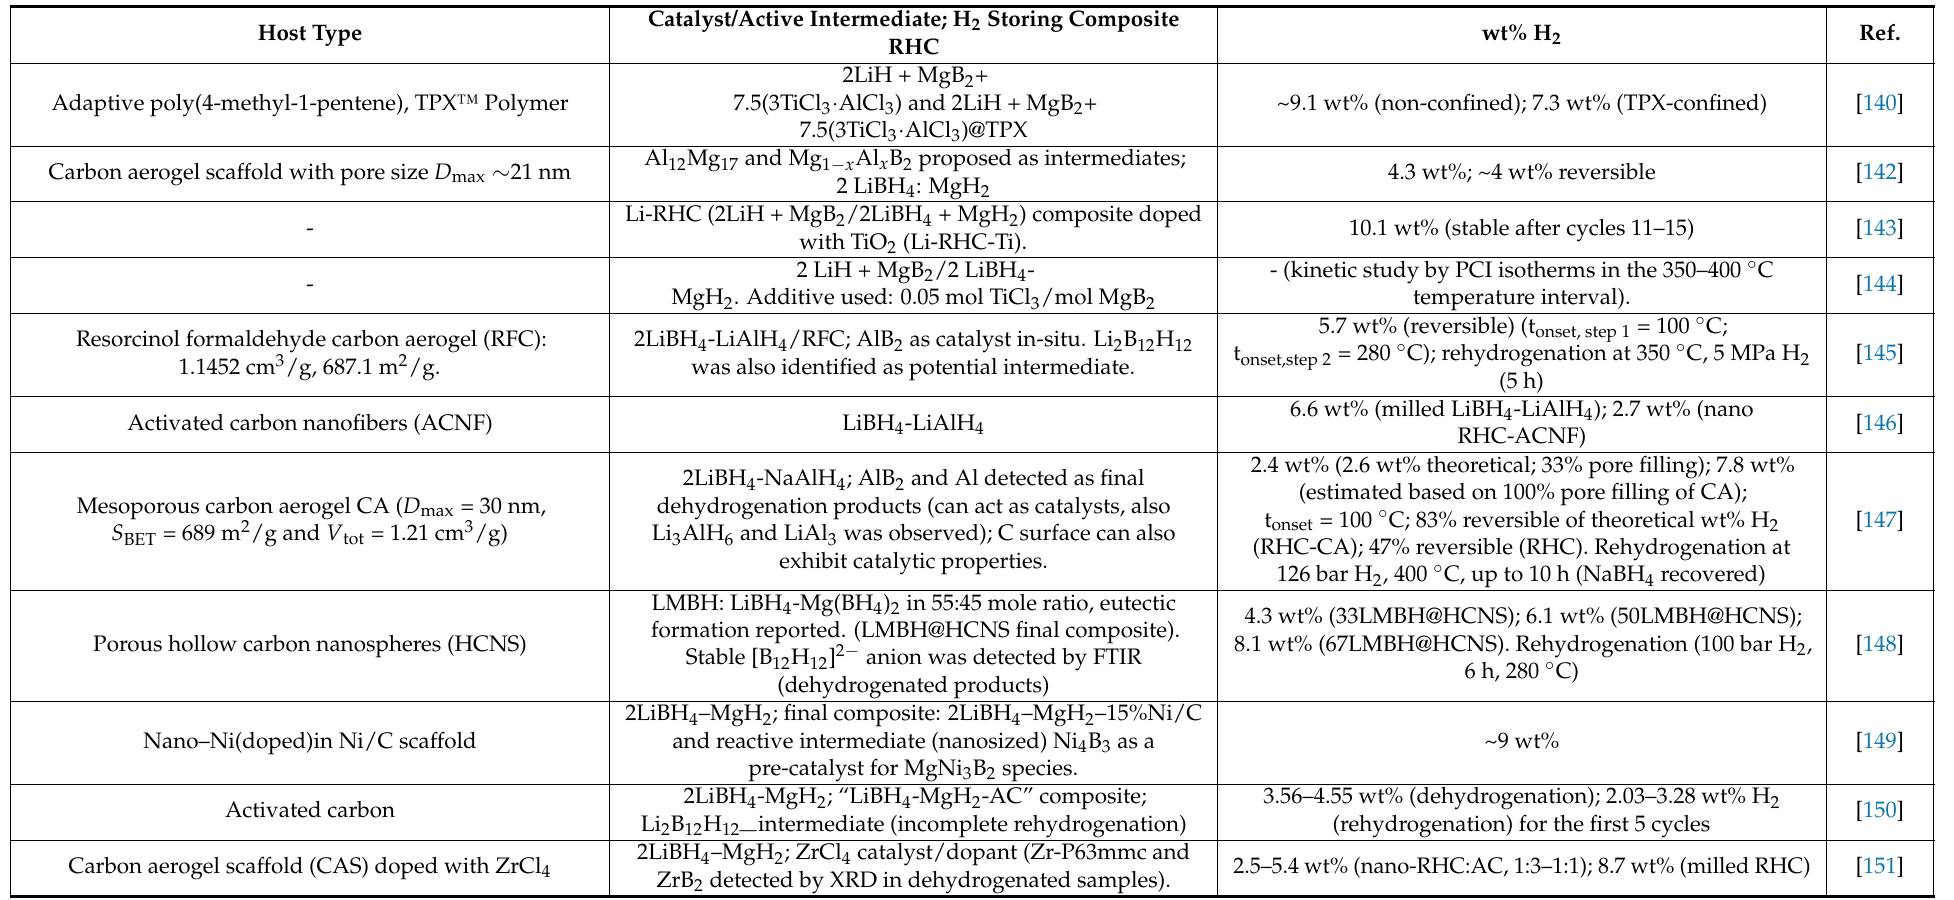
Table 5. Li-RHC-based nanostructured systems and specific details regarding hydrogenation storage